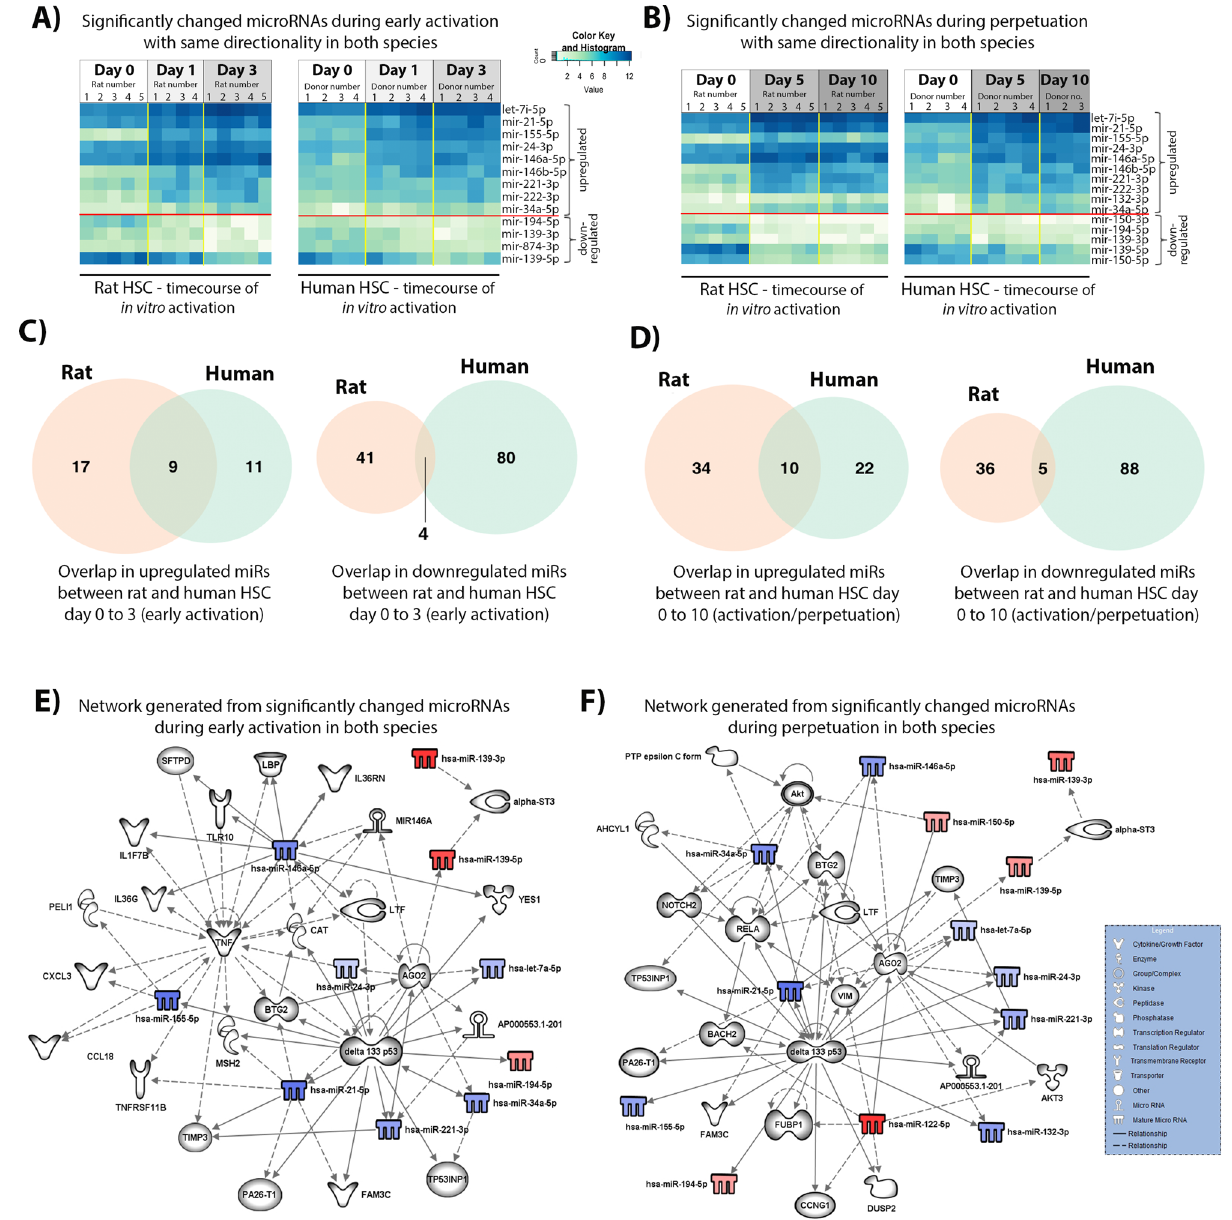
Figure 6. Significantly different miRNA with the same directionality of expression change in both rat and human species. ( A ) Heatmaps of the significantly changed miRNA during the initiation stage of HSC activation in rat (left) and human (right). ( B ) Heatmaps of the significantly changed miRNA during the perpetuation stage in rat (left) and human (right). ( C ) Venn diagram showing the number of significantly upregulated (left) or downregulated (right) miRs during the initiation stage of HSC activation in rat and human. ( D ) Venn diagram showing the number of significantly upregulated (left) or downregulated (right) miRs during the perpetuation/ full activation stage of HSC activation in rat and human. ( E ) Biological network of significantly differentially expressed miRNA with the same directionality in both species during the early stages of HSC activation. In blue and red, under and over-expressed miRNA, respectively. Shadowed in grey are molecules related to miRNA, as displayed on the legend. Lines represent different relationships between the molecules and miRNA. ( F ) Biological network of significantly differentially expressed miRNA with the same directionality in both species during the perpetuation of HSC activation. In blue and red, under and over-expressed miRNA, respectively. Shadowed in grey are molecules related to miRNA, as displayed on the legend. Lines represent different relationships between the molecules and miRNA. Networks were generated using miRNA from the overlapping between rat and human, however I am not sure how to explain in a fig